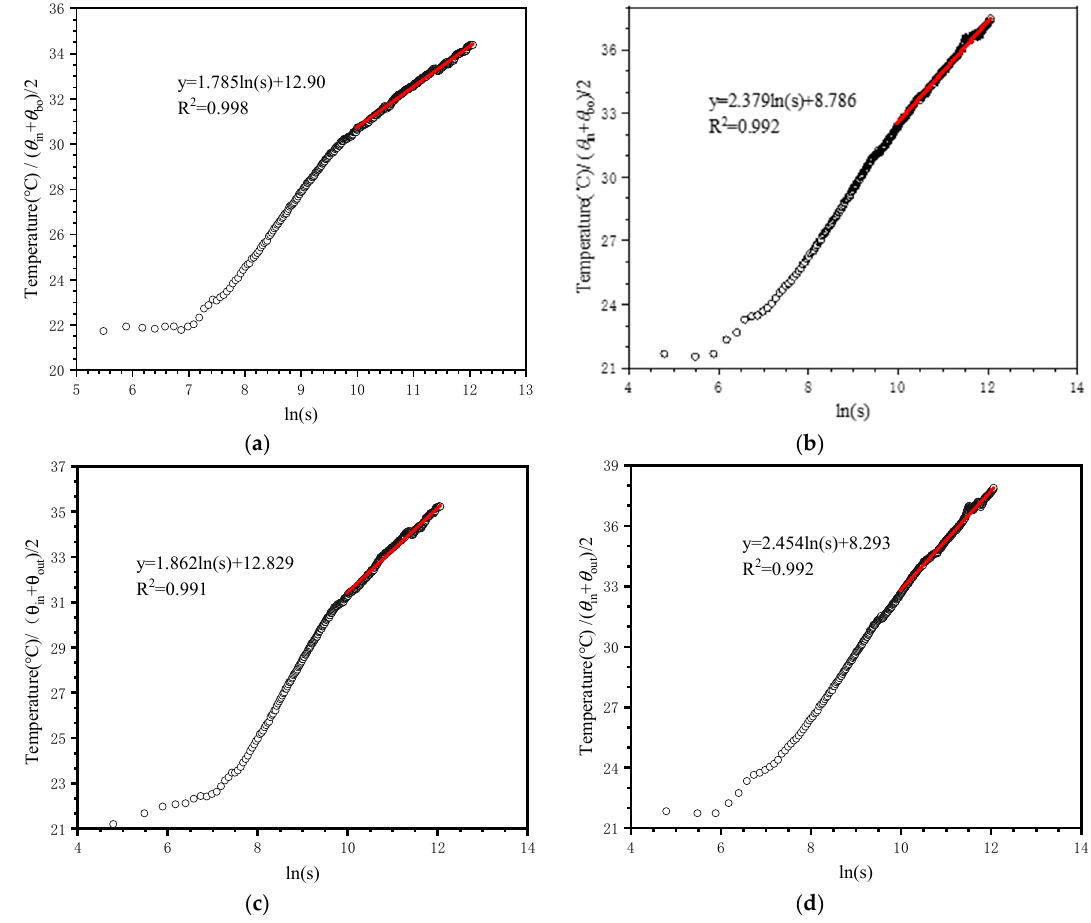
Figure 5. Fluid temperature vs. logarithmic of B1 and B2. ( a ) ITRT result of B1. ( b ) ITRT result of B2. ( c ) TRT result of B1. ( d ) TRT result of B2.